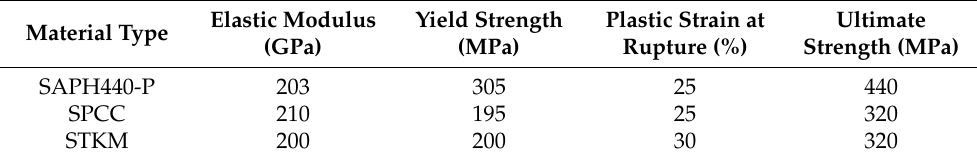
Table 2. Material properties